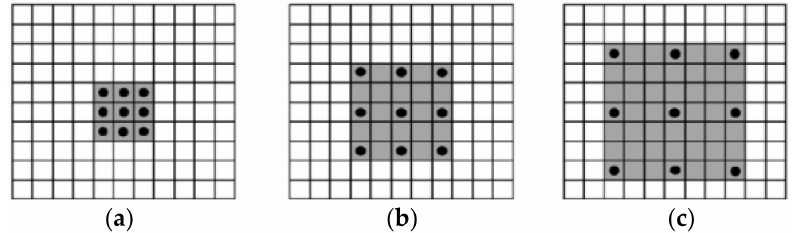
Figure 3. 3 × 3 dilated convolution with different dilated rates. ( a ) dilated rates = 1, ( b ) dilated rates = 2, ( c ) dilated rates =